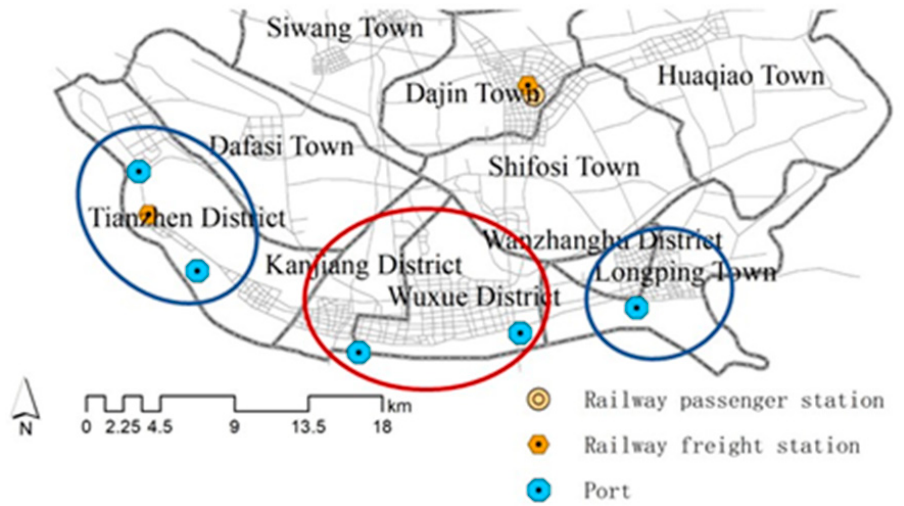
Figure 16. Ports and city bus stop coverage distribution map.